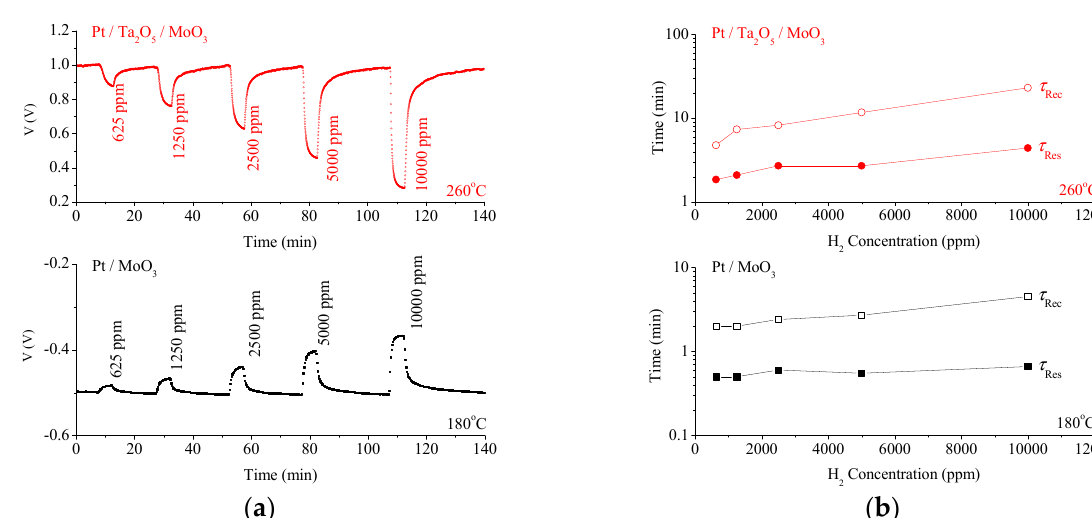
Figure 4. I–V characteristics in air and H 2 for ( a ) the Pt/MoO 3 Schottky contact and ( b ) the Pt/Ta 2 O 5 /MoO 3 heterojunction, at their respective optimal operating temperatures of 180 ° C and 260 ° C. The H 2 gas concentrations are 625, 1200, 2500, 5000 and 10,000 ppm.